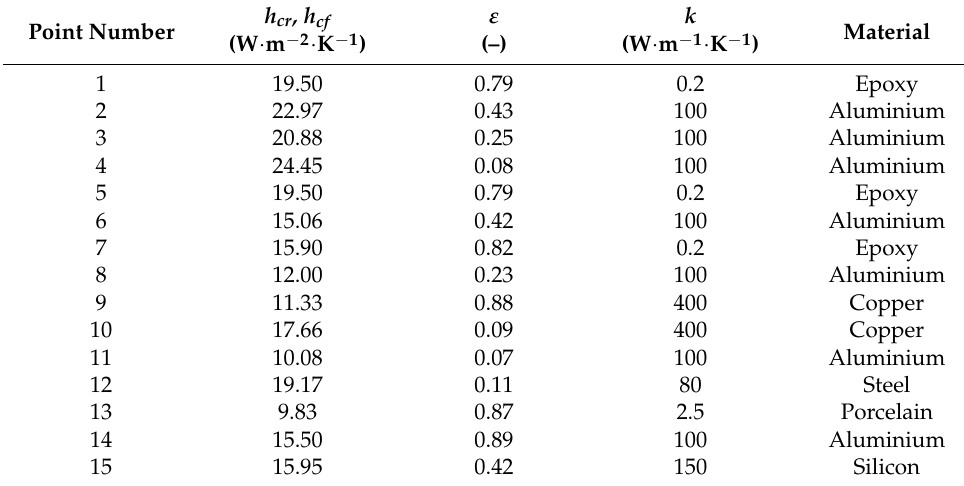
Table 5. Values of the convection coefficient for cylinder h cr , convection coefficient for the flat surface h cf , the value of emissivity coefficient ε , thermal conductivity value, and selected material used in the simulation, where the power dissipated on the P j junction was 13.2 W ( ∆ P j = 0.79